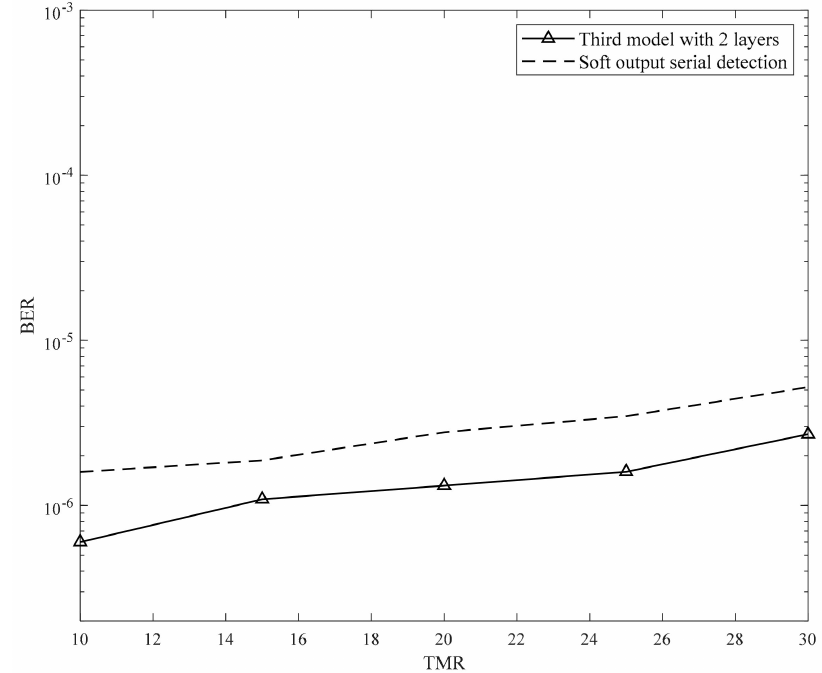
Figure 19. BER versus TMR at 15 dB.